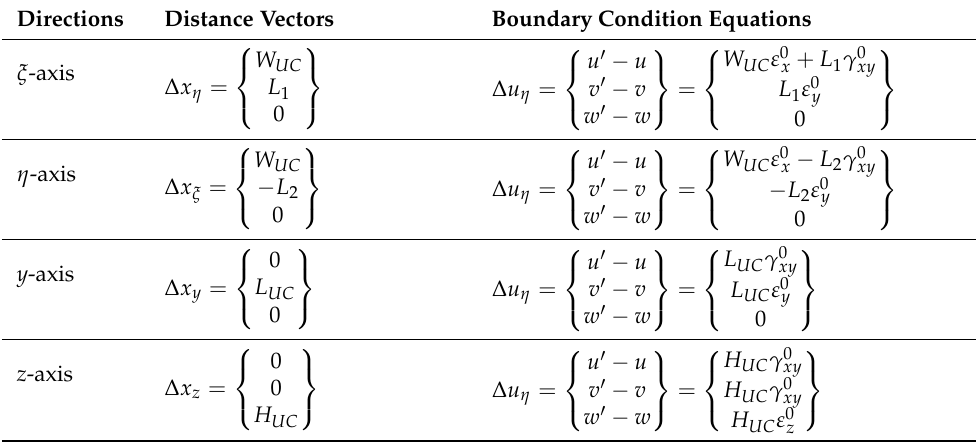
Table 2. Relative displacement boundary conditions for the unit cell model.